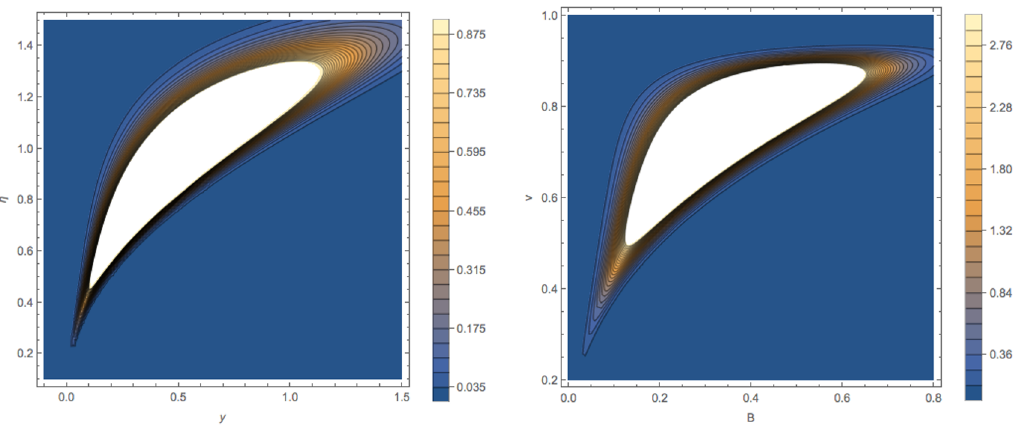
Figure 5 . Probability density function for a worldline centered at ( p, q ) = (1 , 1) in the coordinates ( y, η ) (left) and ( B, v ) (right). In the plot σ